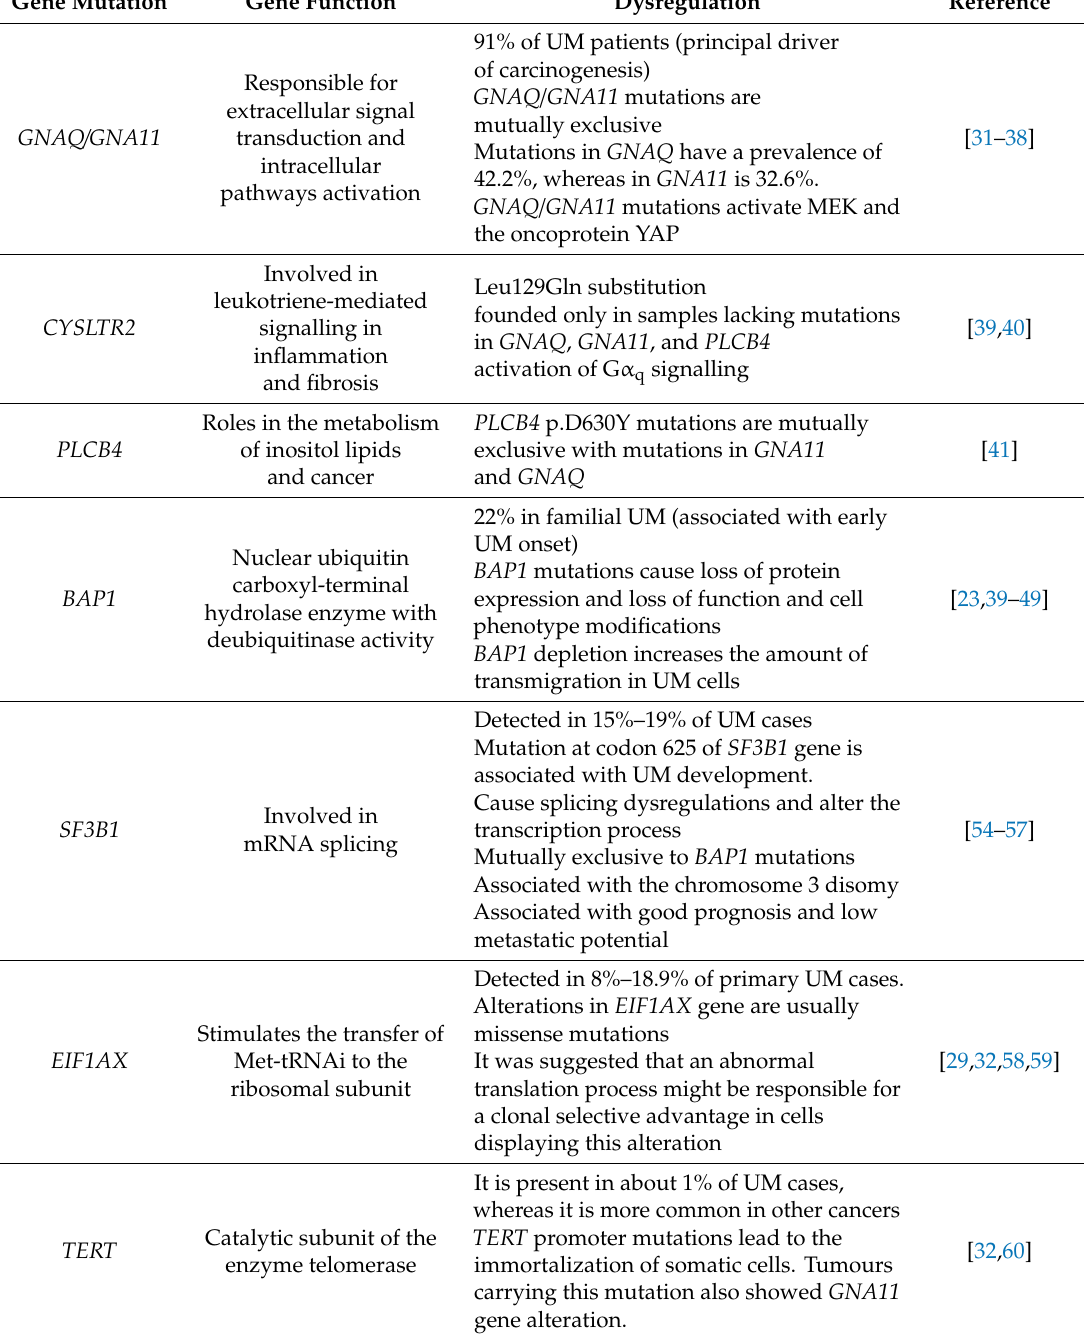
Table 1. Main gene mutations in uveal